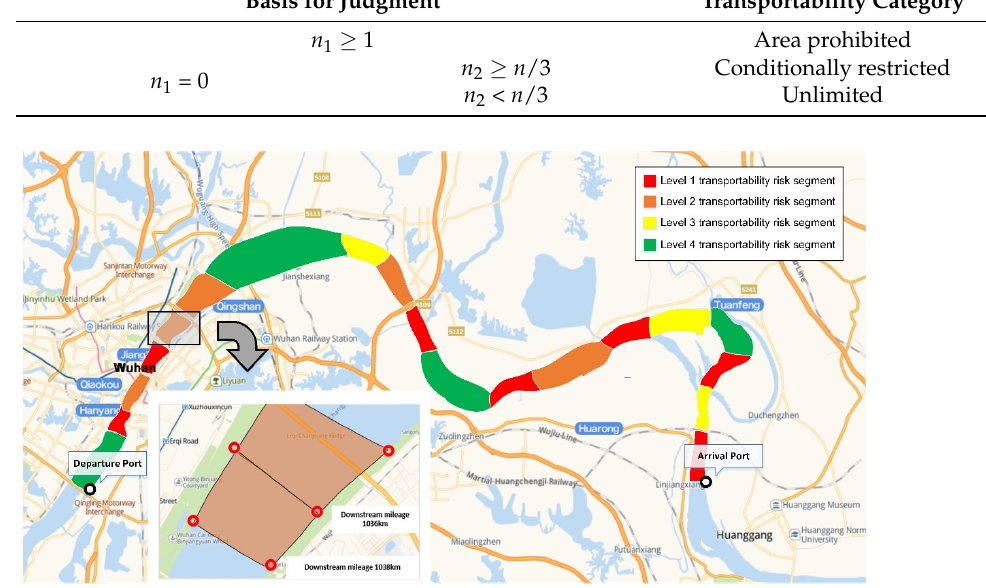
Table 2. Transportability classification table.